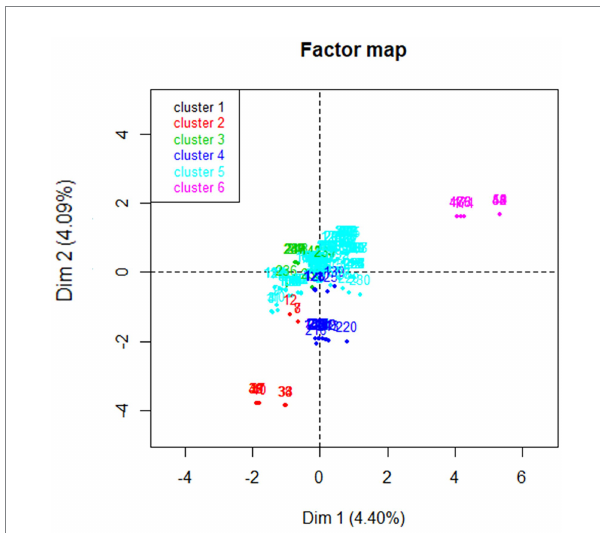
FIGURE 3 Representation of six clusters identified by hierarchical clustering using the results of multiple factor analysis of data collected from beef ranches in California in a cross-sectional study evaluating antimicrobial resistance and antimicrobial drug use in 18 cow-calf operations in northern California between July 2019 and August